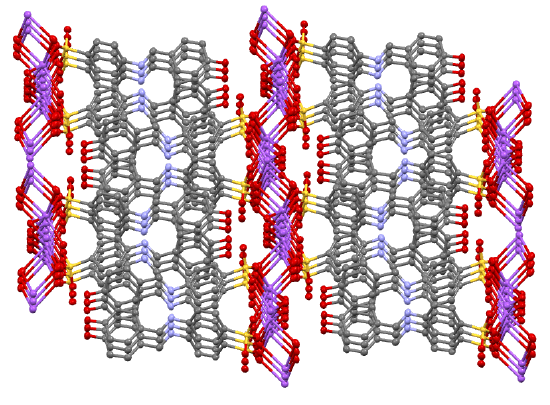
Figure 4: 3D network structure by the interaction of 2D layer.